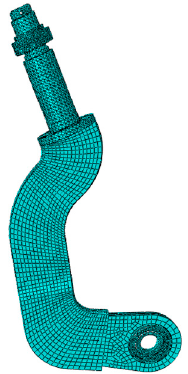
Figure 9. Boom finite element model.